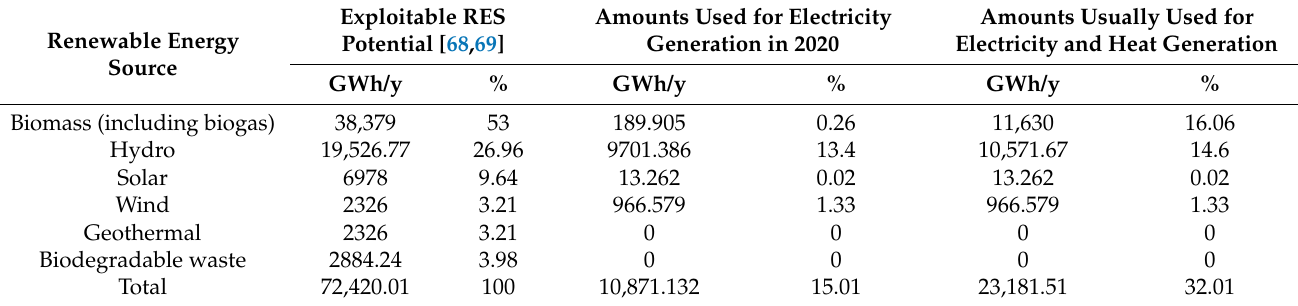
Table 1. Structure of the exploitable RES potential in Serbia